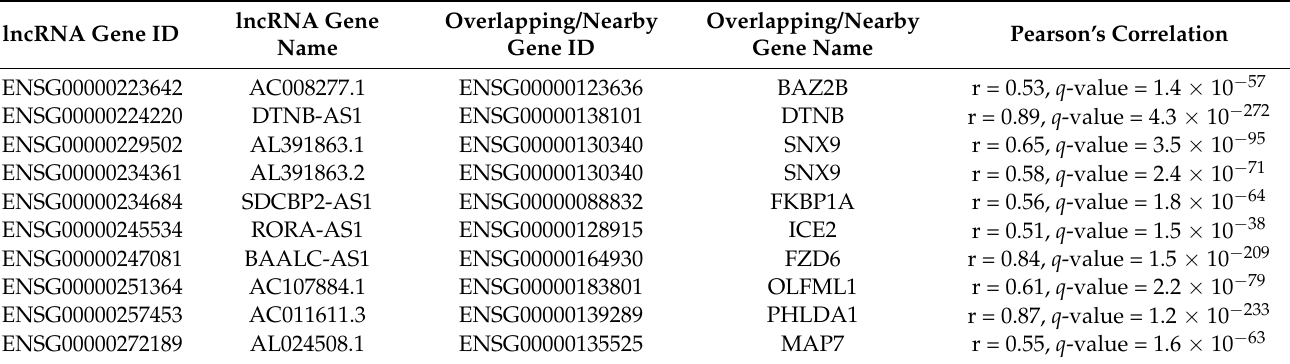
Table 2. List of 10 lncRNAs with a significant Pearson’s correlation with protein-coding